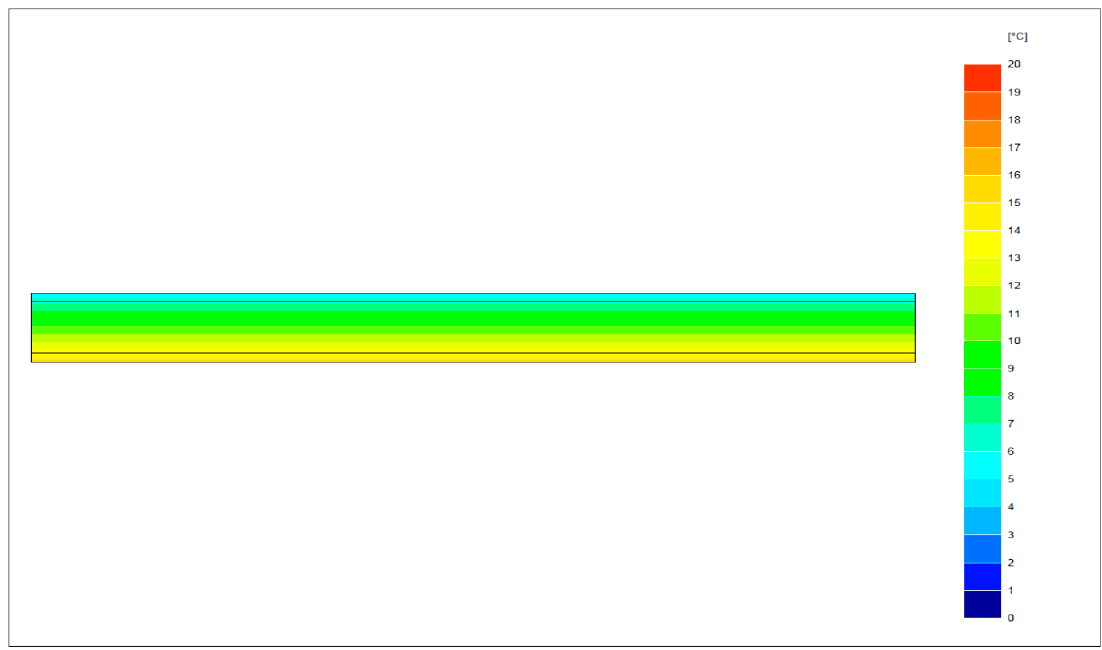
Figure 10. Directly measured temperature distribution along a cross-section of the O2 Arena roof [58].